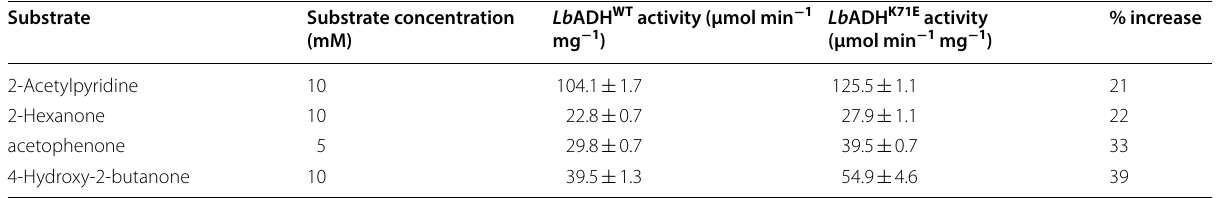
a Mean values and standard deviation based on three separate protein preparations with three technical replicates per preparation b Mean values and standard deviation based on a single protein preparation and three technical replicates